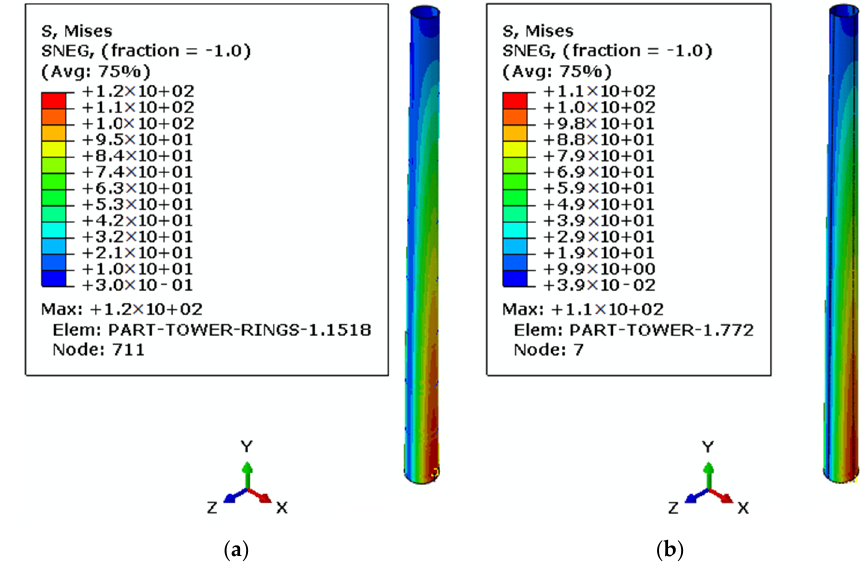
Figure 23. Stress contours of towers I and II in a marine environment. ( a ) Tower I, ( b ) Tower II, (in MPa).